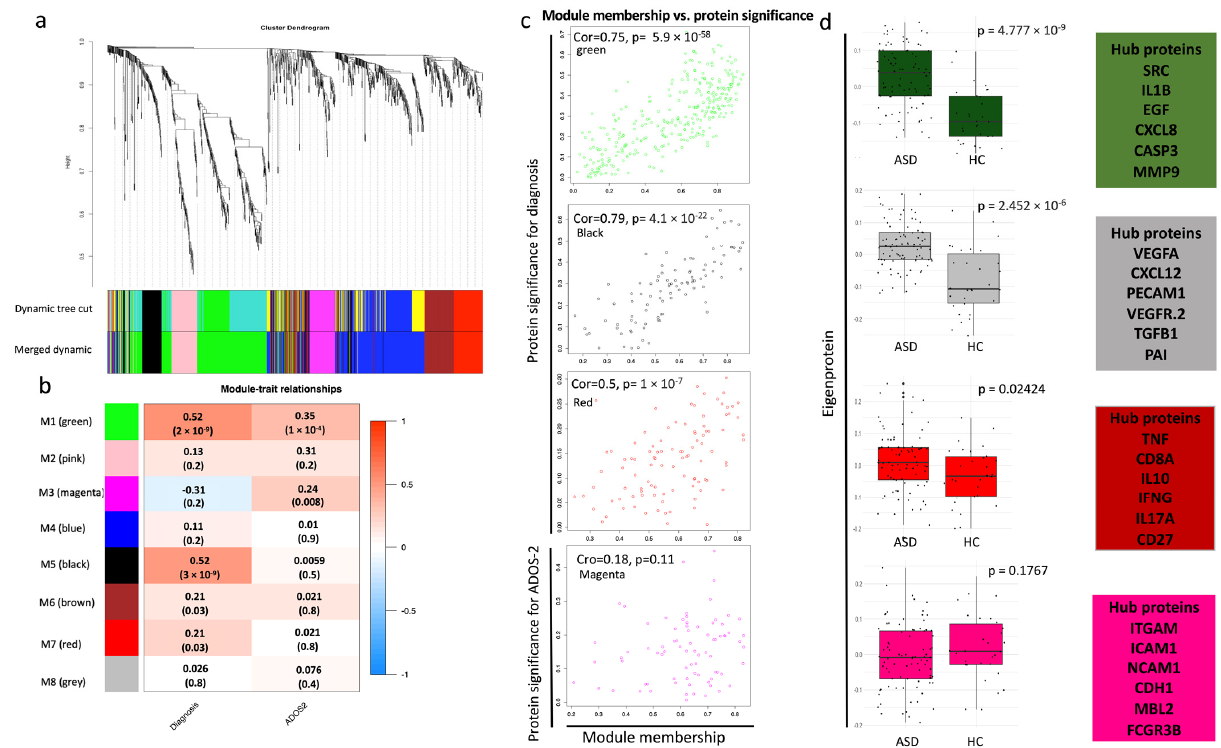
Figure 4. Weighted gene co-expression network analysis (WGCNA). ( a ) Protein dendrogram obtained by average linkage hierarchical clustering of the 1124 proteins. The color bands underneath the dendrogram show the module obtained from the dynamic tree cut. ( b ) The module trait rela- tionship ( p -value and correlation) for the identi fi ed modules in relation to the clinical traits. ( c ) Scat- terplots of protein signi fi cance versus module membership in modules that signi fi cantly correlated with the clinical phenotypes (M1, M3, M5, M7). Protein signi fi cance versus module membership exhibits a signi fi cant correlation. Module membership is each protein’s expression level correlated with the module’s eigengene/epiprotein (the fi rst principal component). For a protein to be assigned to a particular module, its module membership value must be close to 1 or − 1. ( d ) Boxplots of the eigenprotein (the fi rst principal component value of each sample) between ASD cases and HCs in